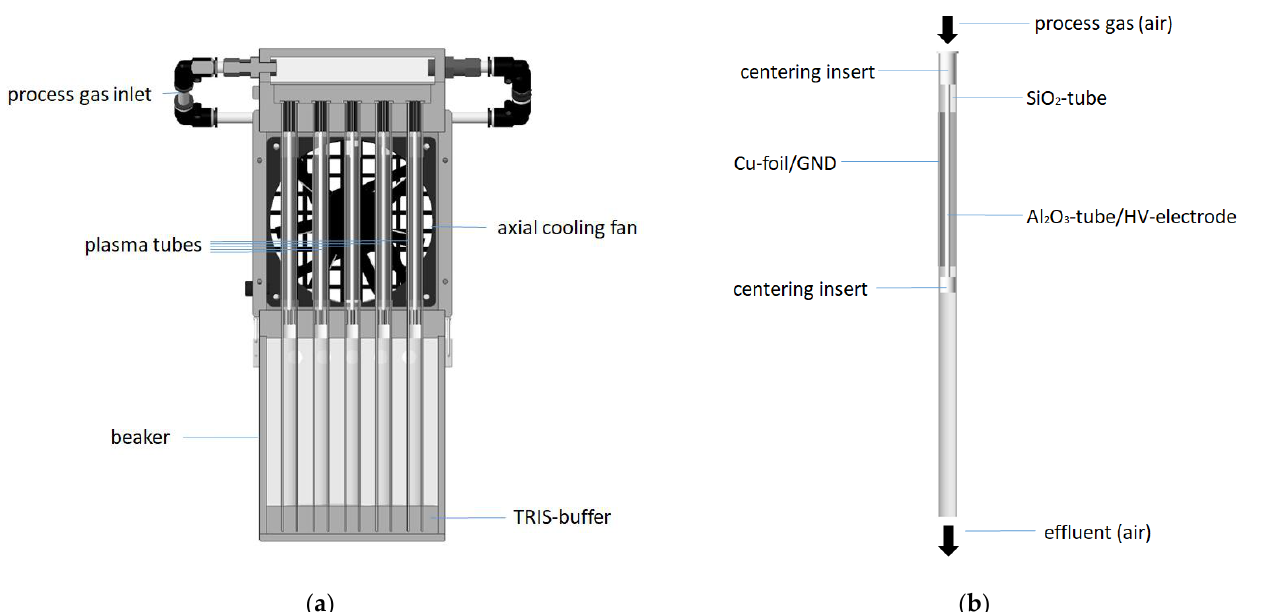
Figure 1. ( a ) Scheme of the plasma tube array to generate Tb-PAW (b) Scheme of the single plasma tube.